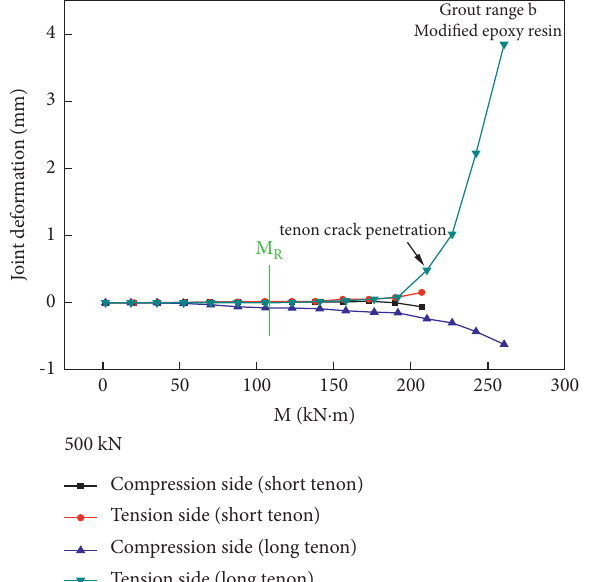
Figure 10: Development law of joint deformation with different axial loads (long single-tenon joint).